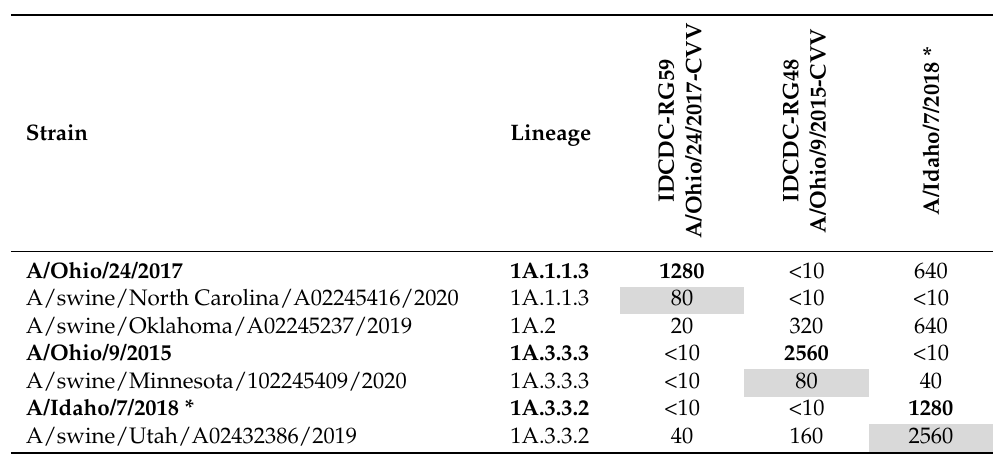
Table 2. Antigenic cross-reactivity of 1A viruses and within-clade CVVs. Ferret antisera raised against CVV and vaccine viruses were tested for the ability to inhibit hemagglutination of contemporary swine viruses. Vaccine strains and homologous titers are bolded; grey highlighted cells indicate the within-clade titer of contemporary swine strain.